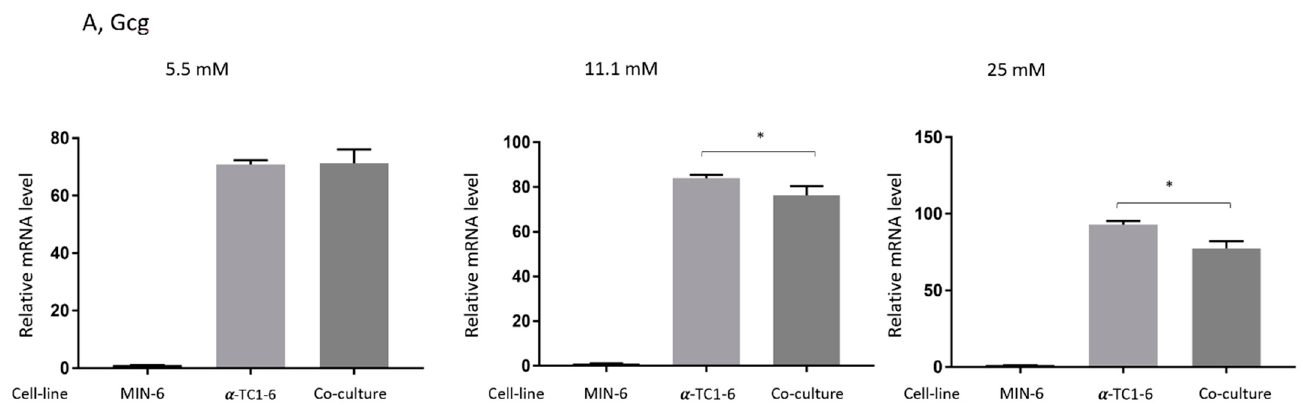
Figure 3. Representative immunocytochemistry microscopic appearance of mono-cultured MIN-6 cells ( i – iii ), mono- cultured α -TC1-6 cells ( iv – vi ), and co-cultured cells ( vii – ix ). Cells were visualized by laser scanning confocal microscopy after 72 h incubation in 5.5, 11.1, or 25 mM glucose. Cells were stained with both antibodies against insulin (green) and glucagon (Pink). In co-cultured conditions ( vii – ix ), MIN-6 cells were indicated by green arrows and α -TC1-6 cells were indicated by pink arrows. Scale bar are representative = 20 μ m. Images of 1 representative view for each condition are shown (n = 5).